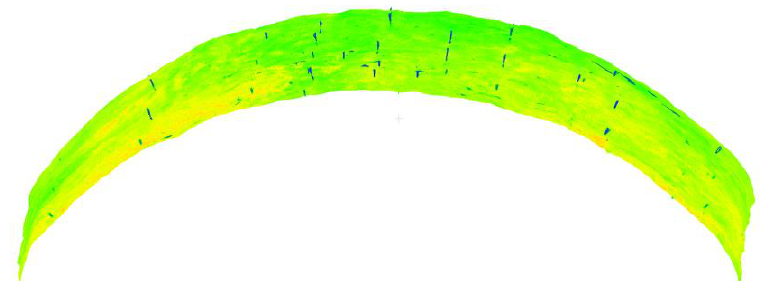
Figure 3. Experimental dataset.